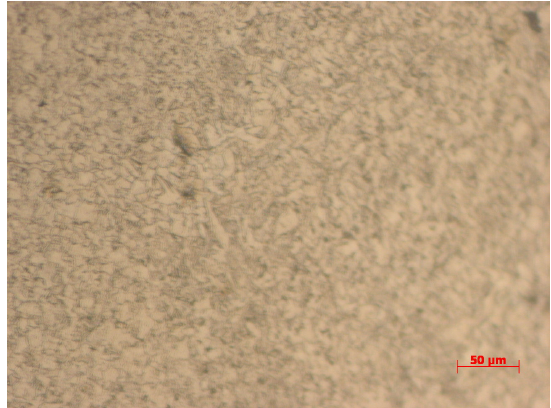
Figure 3. Microstructure after heat treatment at 1273 K followed immediately by water